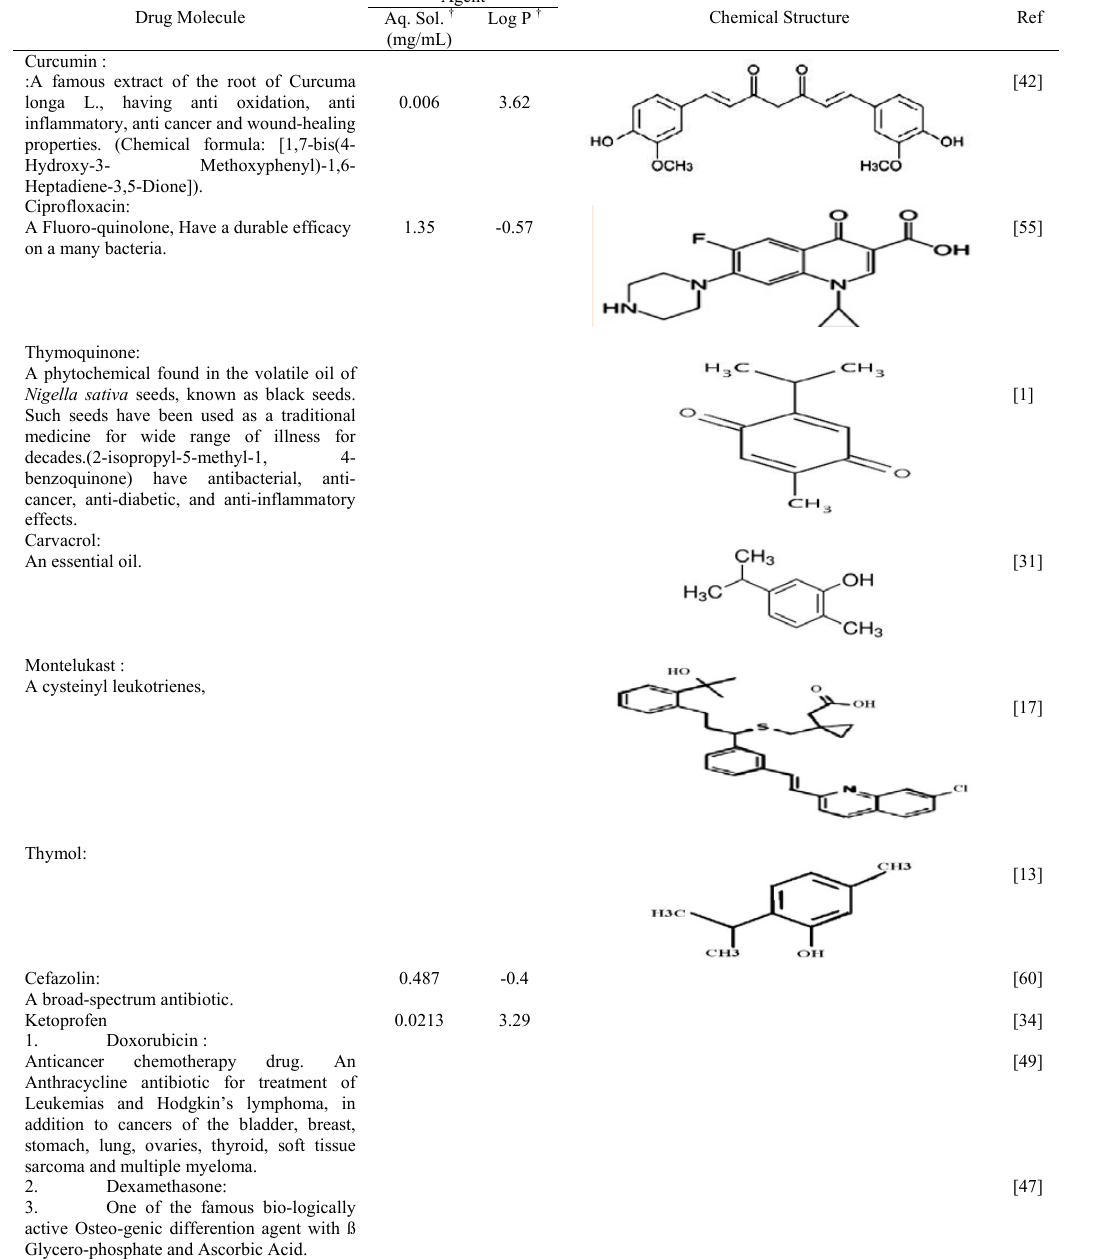
Table 2. Characteristics of molecule drugs used in PLA Nano-fiber drug-delivery systems. Drug Molecule